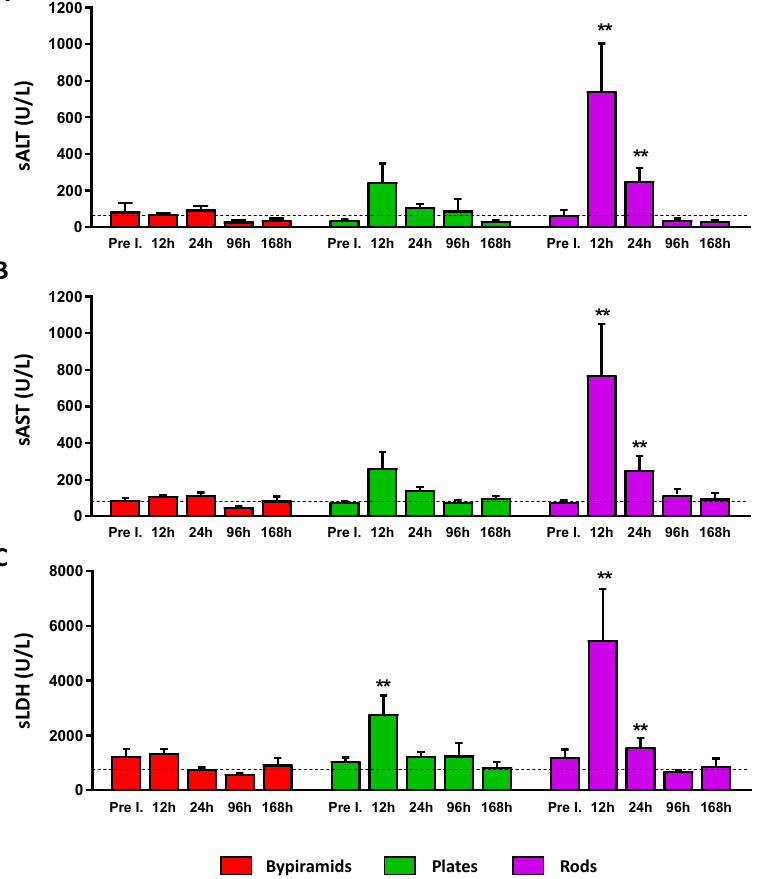
Figure 6. In vivo hepatic toxicity. Activity (Units/Liter [U/L]) of serum ALT ( A ), AST ( B ), and LDH ( C ) measured at the indicated time points in groups of mice injected with bipyramids, plates, and rods. The dashed lines indicate the upper value of normality of each variable (70 U/L for ALT, 83 U/L for AST, and 750 U/L for LDH). Pre I. = Pre injection. The values are expressed as mean ± SEM. An unpaired T-test was carried out; significant difference (** p < 0.01) when comparing NP-treated and vehicle-treated mice at the same time point is